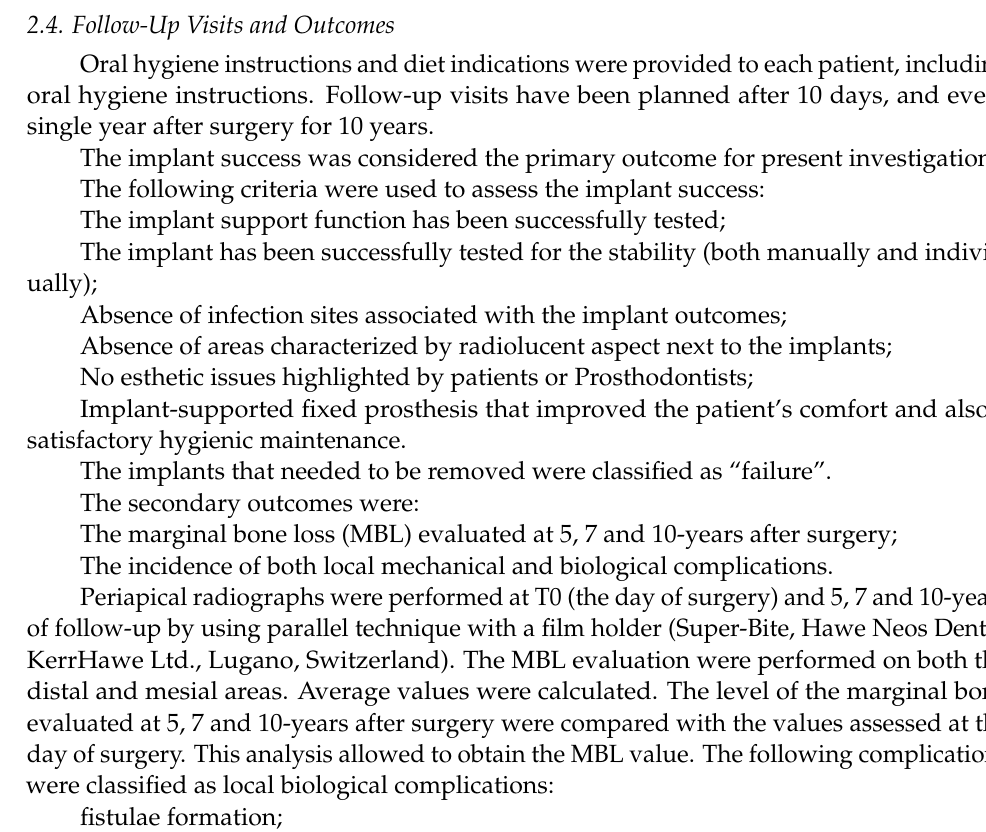
Figure 1. Percentage of Implants placed in teeth sites on mandibular bone.